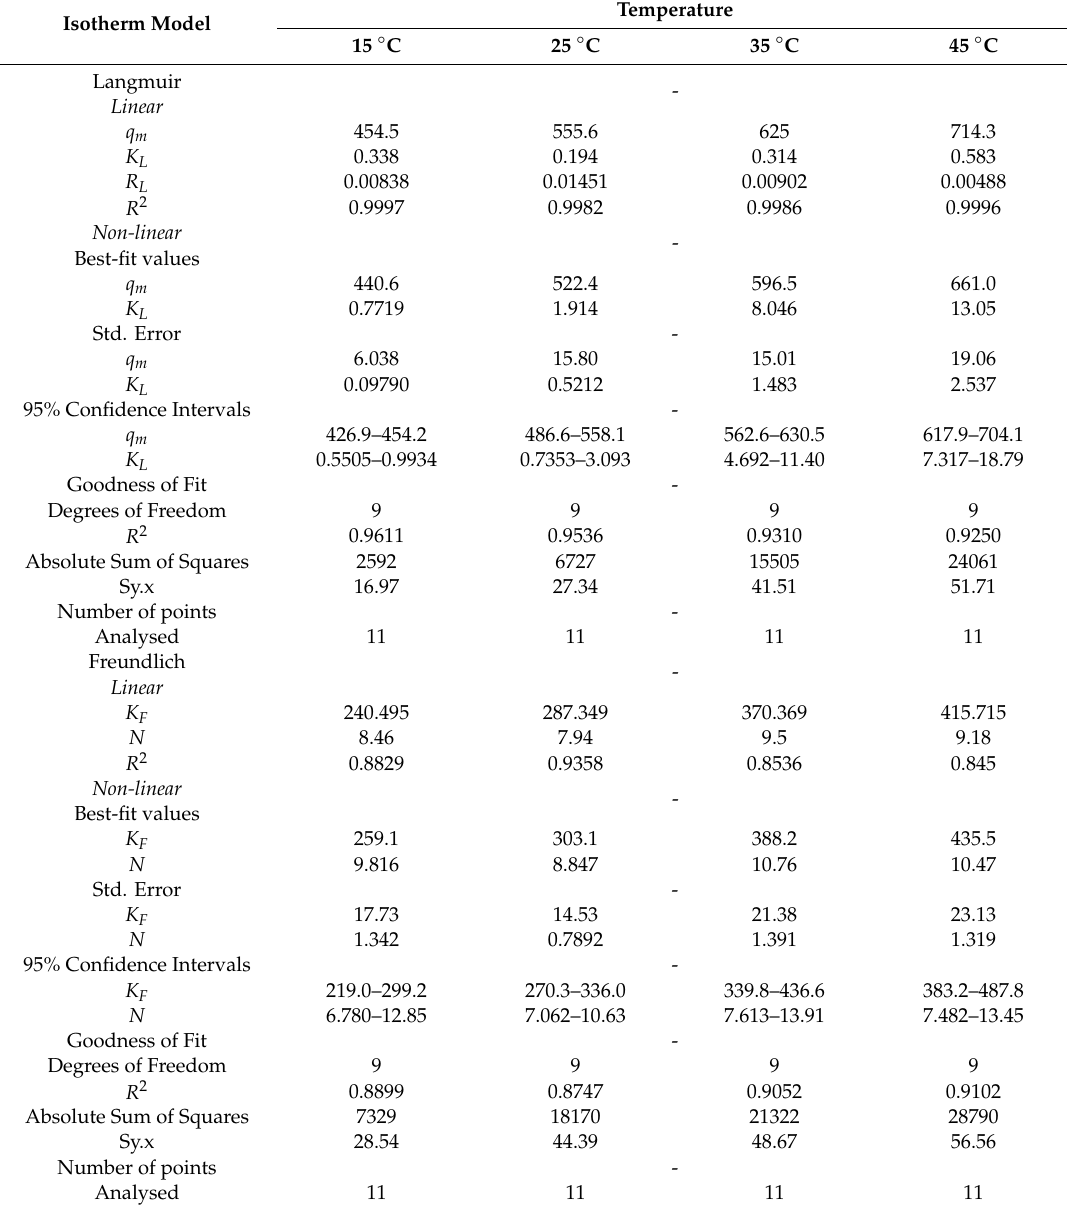
Table 1. Isotherm parameters for Cr(VI) adsorption by PPy– m PD / Fe 3 O 4 using both Langmuir and Freundlich